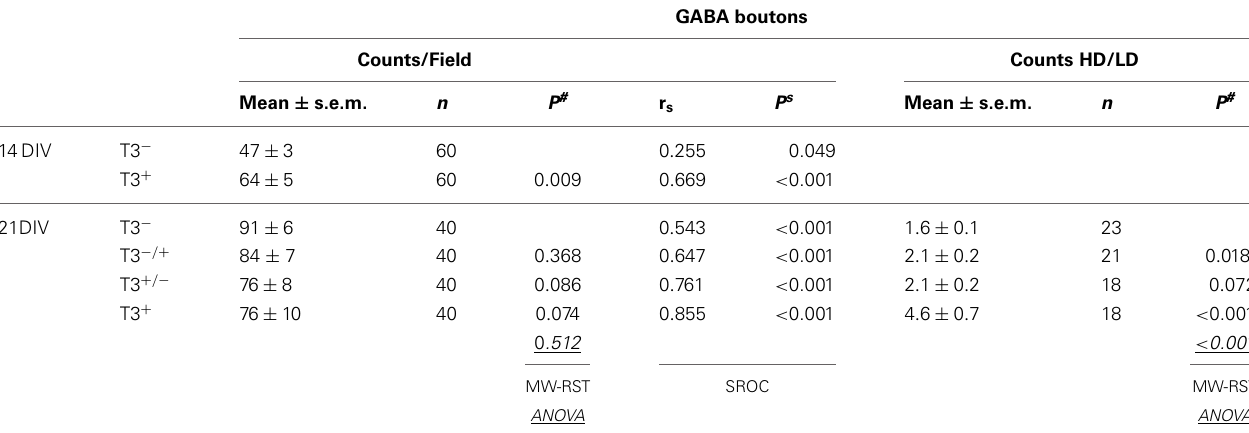
Table 3 | Summary of L-GABAergic bouton counts.